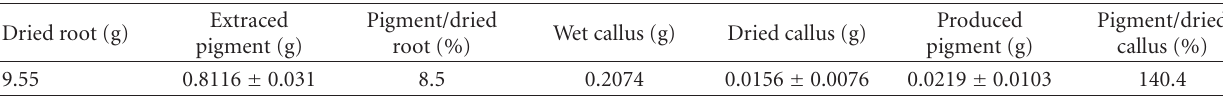
Table 1: The average amount of shikalkin pigment extracted from 5 samples of the natural Iranian A. euchroma roots and 5 pieces (taken from 5 di ff erent petri dishes) of the A. euchroma calli subcultured on mM9 [supplemented by IAA (10 − 6 M), kinetin (10 − 5 M), and sucrose 25g/L) maintained in the dark at 25 ◦ C for 3 weeks.